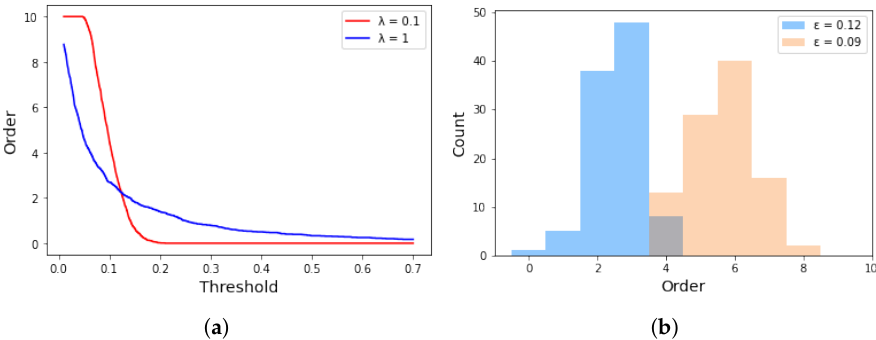
Figure 5. Effects of threshold on orders. ( a ) Relationship between threshold and mean of orders. ( b ) Relationship between threshold and distribution of orders.